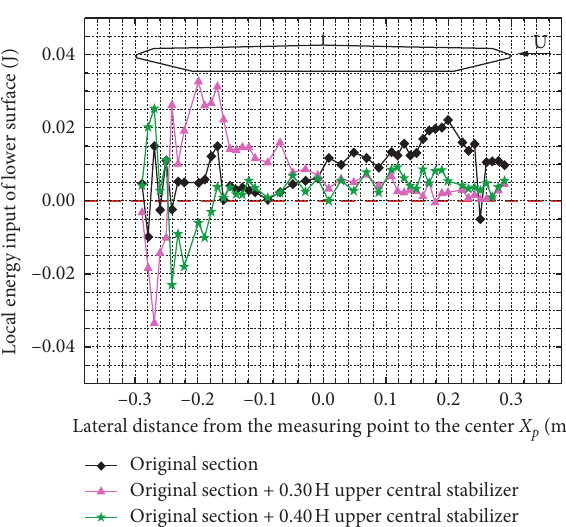
Figure 14: Local energy input of the lower surface.